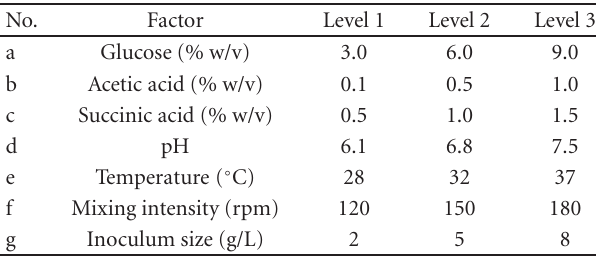
Table 1: The selected fermentation factors and their assigned